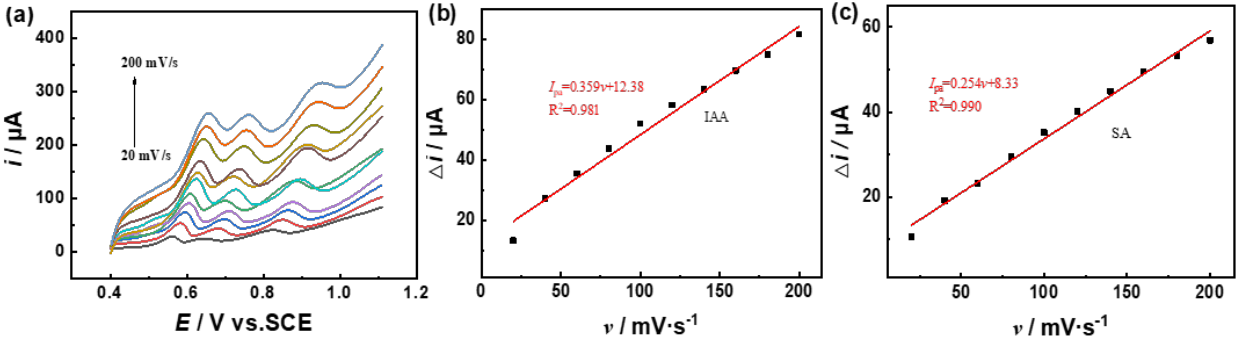
Figure 6. ( a ) LSV curves of PPRONPs–CDs–MWCNTs/GCE in PBS (pH = 7) containing 50 µ M IAA and 50 µ M SA at different scan rates. ( b ) The linear correlation of peak current of IAA vs. the scan rates. ( c ) The linear correlation of peak current of SA vs. the scan rates.